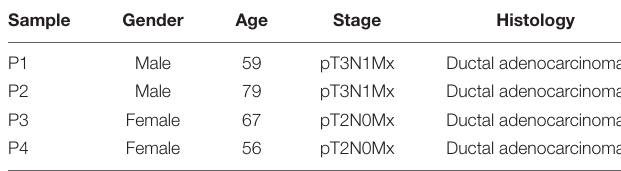
TABLE 1 | Clinical information of PDAC